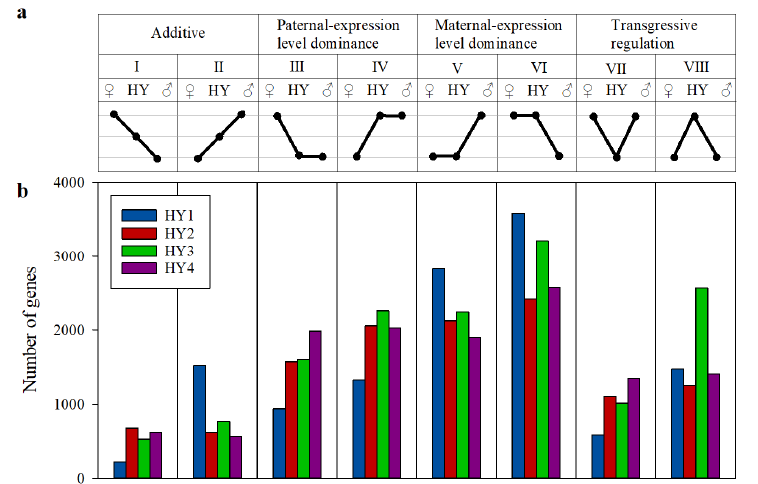
Figure 3. Gene expression inheritance patterns in the cabbage hybrids. ( a ) The eight different gene expression inheritance patterns based on the hybrid gene expression level compared to its parents: additive (I and II), paternal expression level dominance (low-parent dominance and high-parent dominance; III and IV), maternal expression level dominance (low-parent dominance and high-parent dominance; V and VI), transgressive regulation (upregulation and downregulation; VII and VIII). ( b ) The number of genes representing each expression inheritance category in the four hybrids. To further evaluate the maternal expression bias, we selected the genes with parent- specific SNPs and determined relative allele-specific expressions (ASEs), the percentage of female parent alleles in the transcriptome (% FP HY ). In each hybrid, representation of female parent alleles in the transcriptome for approximately 41–48% of the genes was be- tween 40–60% (40–60 category in Figure 4a), and therefore, these genes showed no clear expression bias [31]. For the remaining genes, HY1 and HY3 showed a maternal bias (60– their expression in the hybrids (FP HY /MP HY ) on a logarithmic scale (Figure 4b). The distributions of alleles in these plots were mostly symmetrical and showed no clear bias to either parent. However, in HY1, more gene position in the upper quadrants indicates higher expressions of FP alleles (Figure 4b).